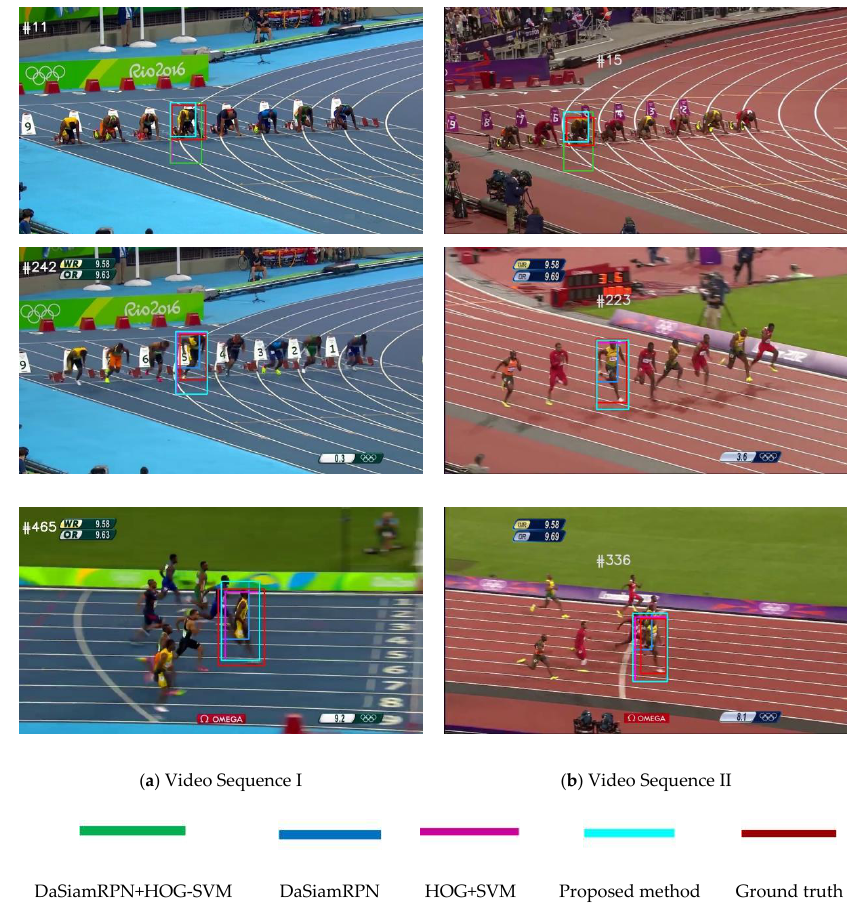
Figure 15. Qualitative results of our proposed tracking method, along with DaSiamRPN,